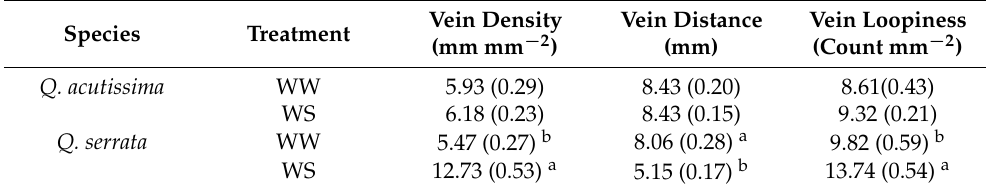
Table 1. Effects of well-watered (WW) and water-deficit stress (WS) on vein density, distance, and loopiness of Quercus acutissima and Q. serrata after eight weeks. Different lowercase letters indicate significant differences between treatments at α = 0.05. Values in parenthesis are the standard errors (n = 10). Still-green leaves were the ones harvested for leaf anatomical traits measurement.